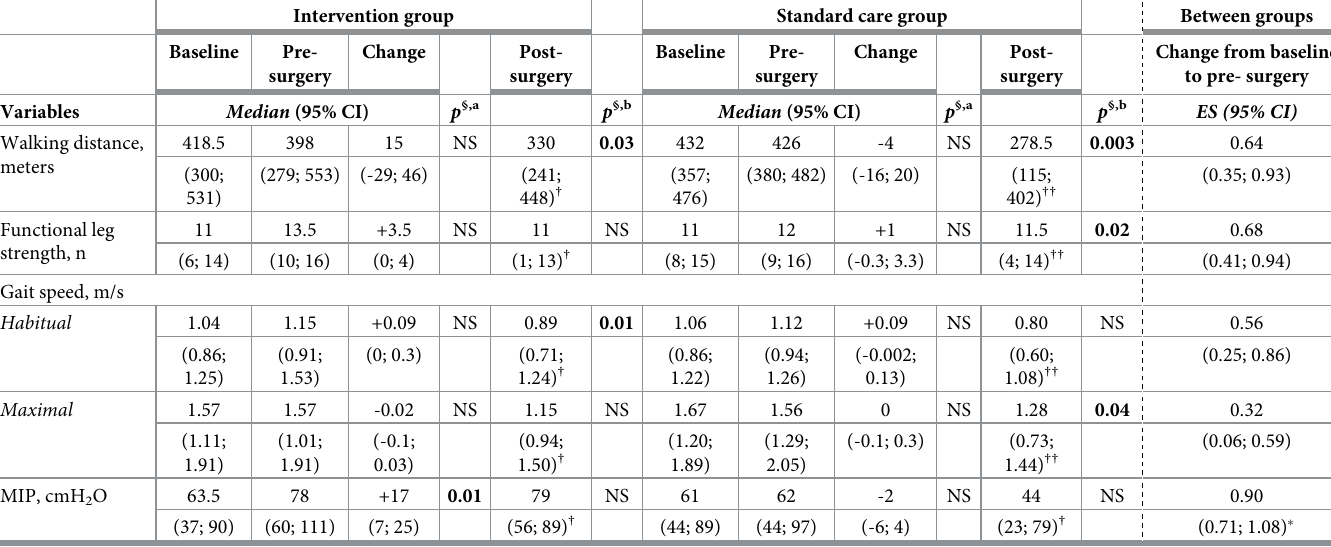
Table 5. Physical performance during the perioperative period within and between the intervention (n = 10) and standard care (n = 11)